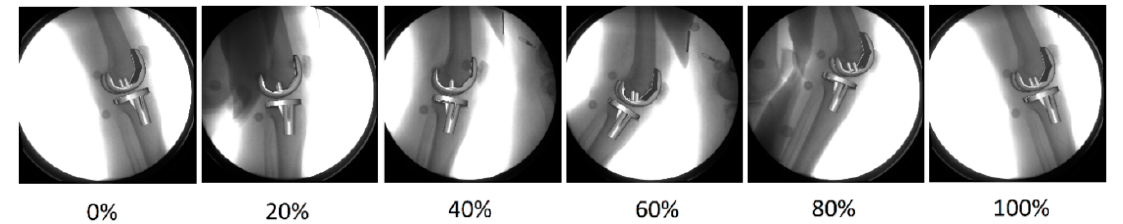
Figure 1. Subject-specific 3D implant geometries were registered to the 2D images of the knee captured by the moving fluoroscope. Exemplary images show a subject’s knee at different time points during a level gait cycle (time as a percentage of the gait cycle is reported below each picture).